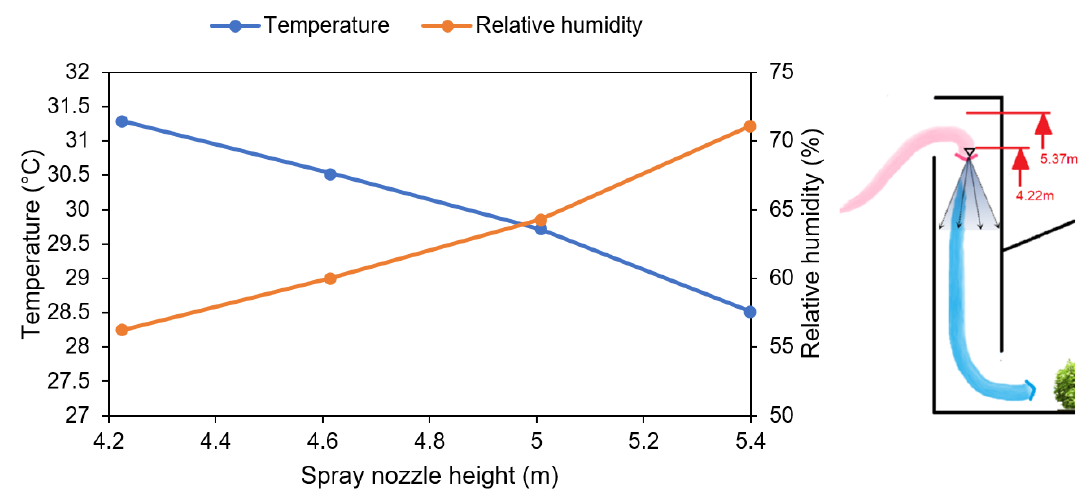
Figure 15. The influence of spray nozzle height on the temperature reduction and indoor relative ◦ C, RH = 24.5%, U = 4.4 m / humidity (outdoor T = 40 °C, RH = 24.5%, U HWC = 4.4 m/s). humidity (outdoor T = 40 HWC